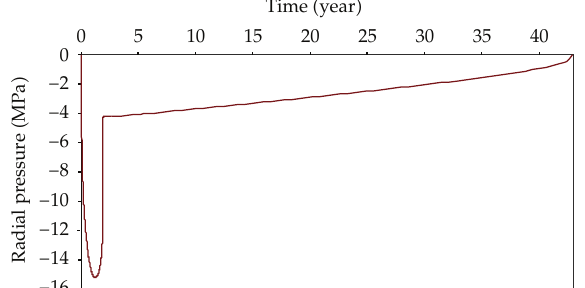
Figure 9: Radial pressure (cid:5) σ r (cid:6) at rebar surface with time t .